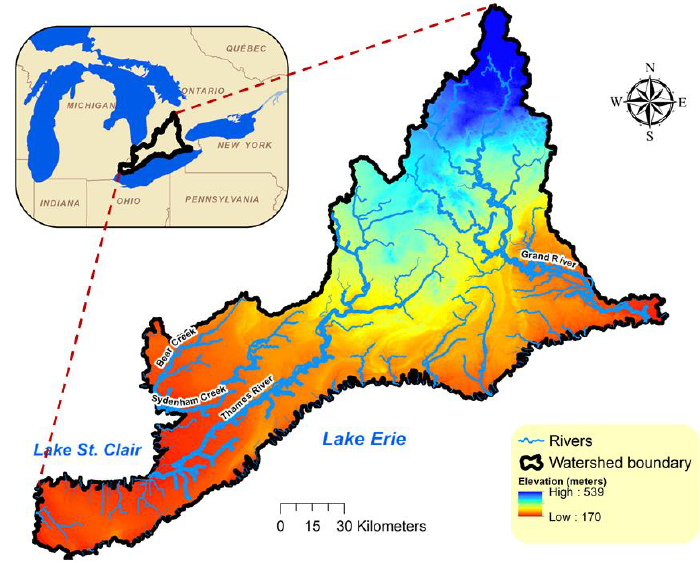
Figure 1. Study area location map—Northern Lake Erie basin, Ontario, Canada.